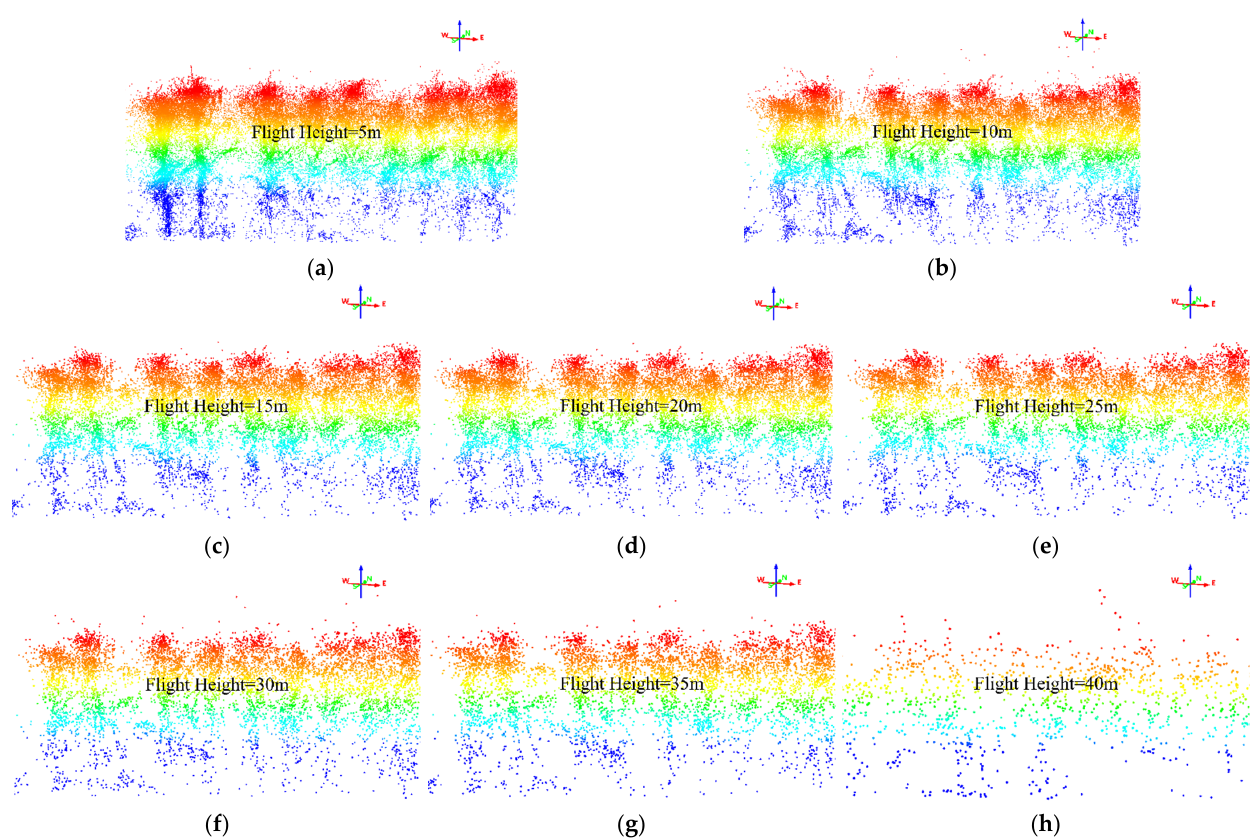
Figure 6. Side views of maize point cloud data in the same plot of different flight heights: ( a ) flight height = 5 m; ( b ) flight height = 10 m; ( c ) flight height = 15 m; ( d ) flight height = 20 m; ( e ) flight height = 25 m; ( f ) flight height = 30 m; ( g ) flight height = 35 m; ( h ) flight height = 40 m.